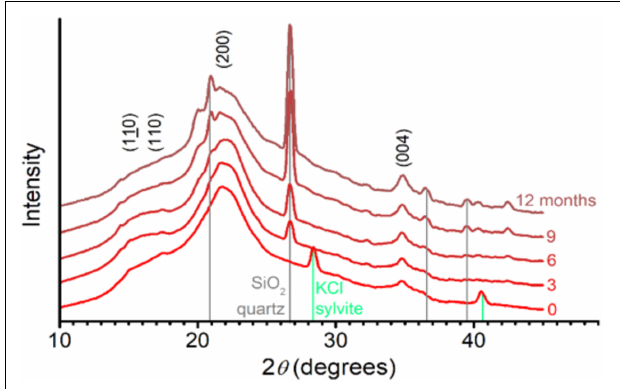
FIGURE 6 | X-ray diffraction patterns of sugarcane straw aged in the field from 0 to 12 months. The main diffraction lines from crystalline cellulose (110, 110, 200, and 004) and contaminants – quartz (gray) and sylvite (green) – are indicated. Intensity is normalized and shifted for better visualization.